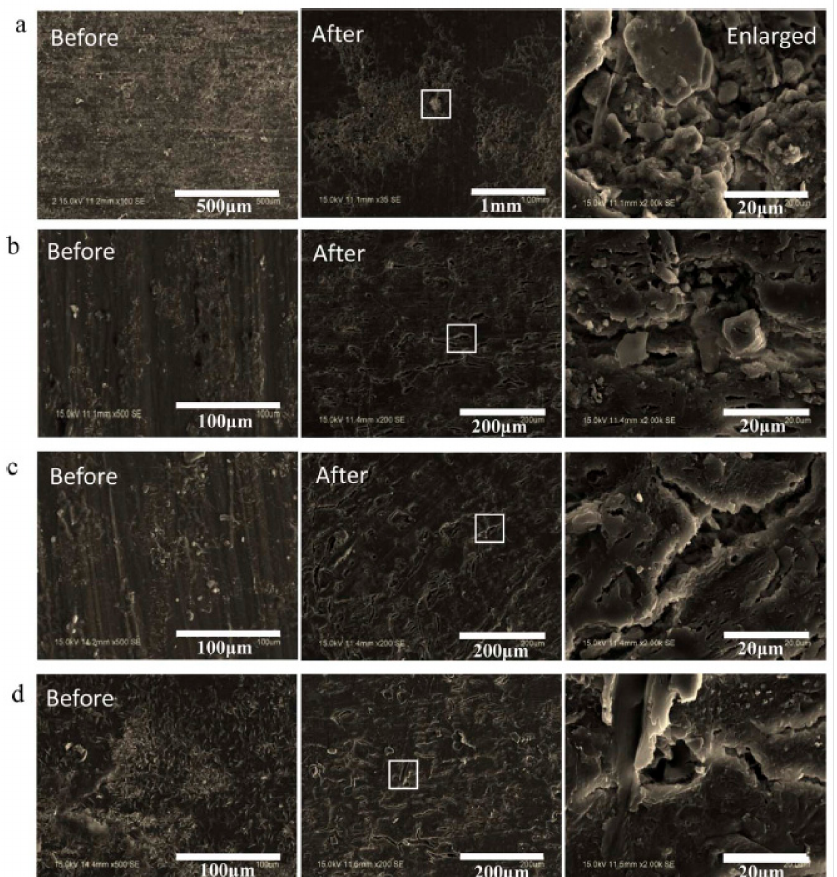
Figure 19. SEM images of pure PBS and sugarcane rind fiber (SRF)/PBS composites at various SRF contents before and after 100 days of soil burial: ( a ) pure PBS, ( b ) 5 wt.% SRF, ( c ) 10 wt.% SRF and ( d ) 15 wt.% SRF [143]. Copyrights obtained from Elsevier.